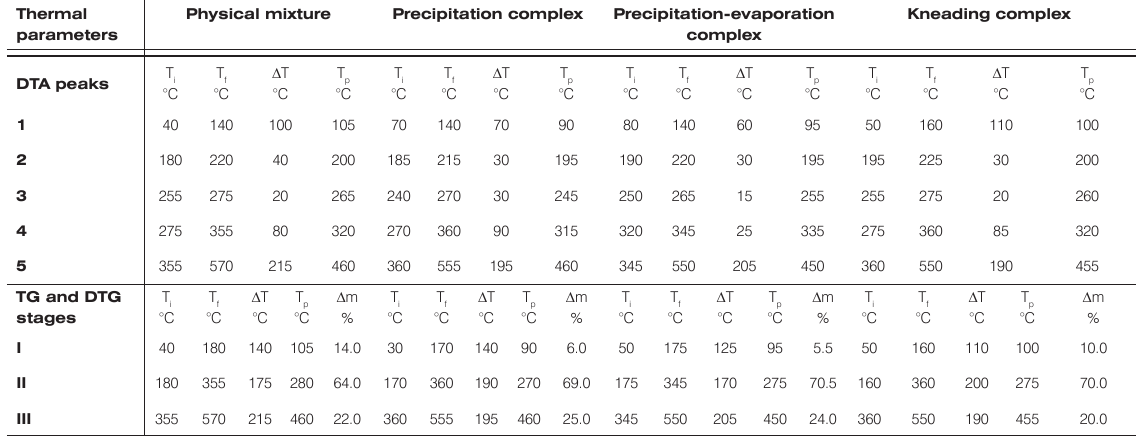
Table 2. DTA, TG and DTG data sets for physical mixture and inclusion complexes of salicylamide with β -cyclodextrin. Thermal